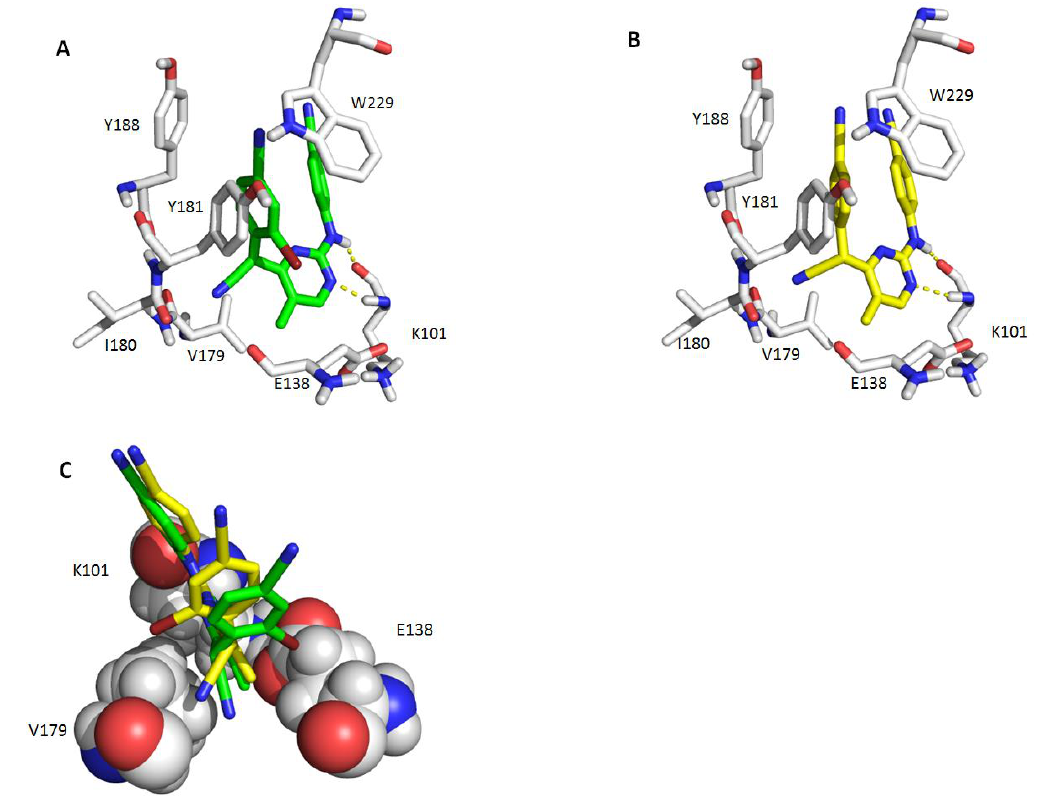
Figure 4. Predicted binding modes of compound B4 with RT (PDB: 2ZD1). ( A ) RT with S -B4 (green); ( B ) RT with R -B4 (yellow); ( C ) The space-filling model for the predicted binding mode of S -B4 (green) and R -B4 (yellow). The carbons of the compounds are depicted in green or yellow. Residues involved in interactions are shown as gray sticks. Hydrogen bonds are depicted as yellow dashed lines.